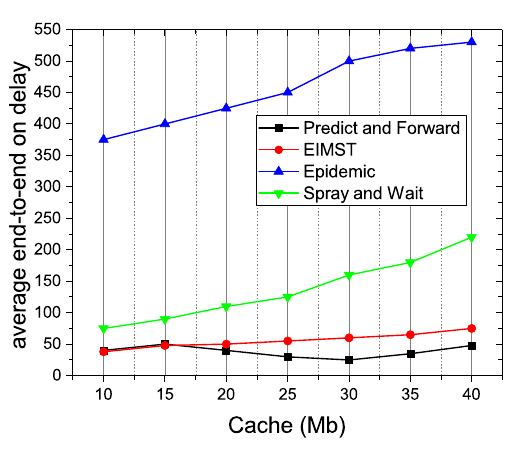
Figure 12. Average end-to-end